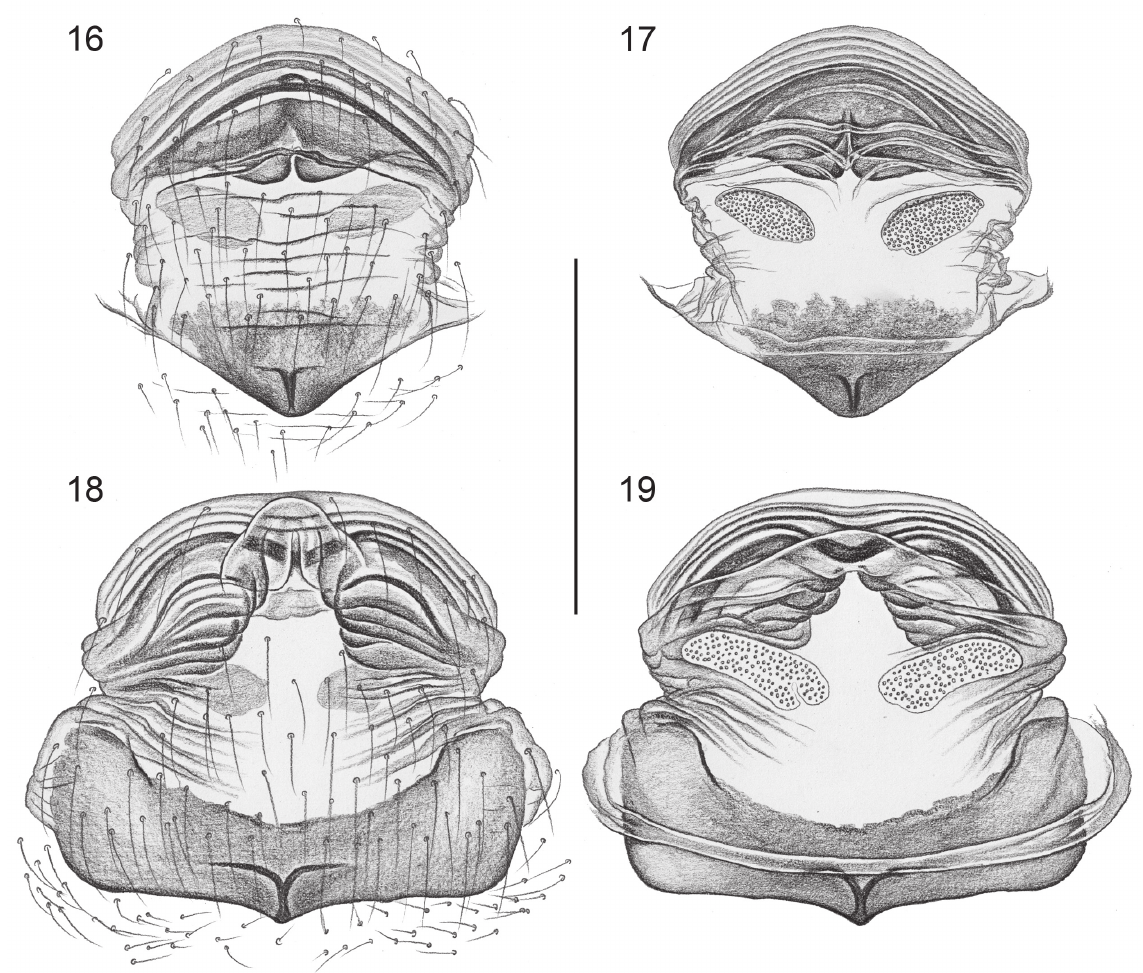
Figs 16–19. Aetana ocampoi Huber, sp. nov. Cleared female genitalia of morph A (16–17) and morph B (18–19), in ventral (left) and dorsal (right) views. Scale line: 0.5 mm (all at same